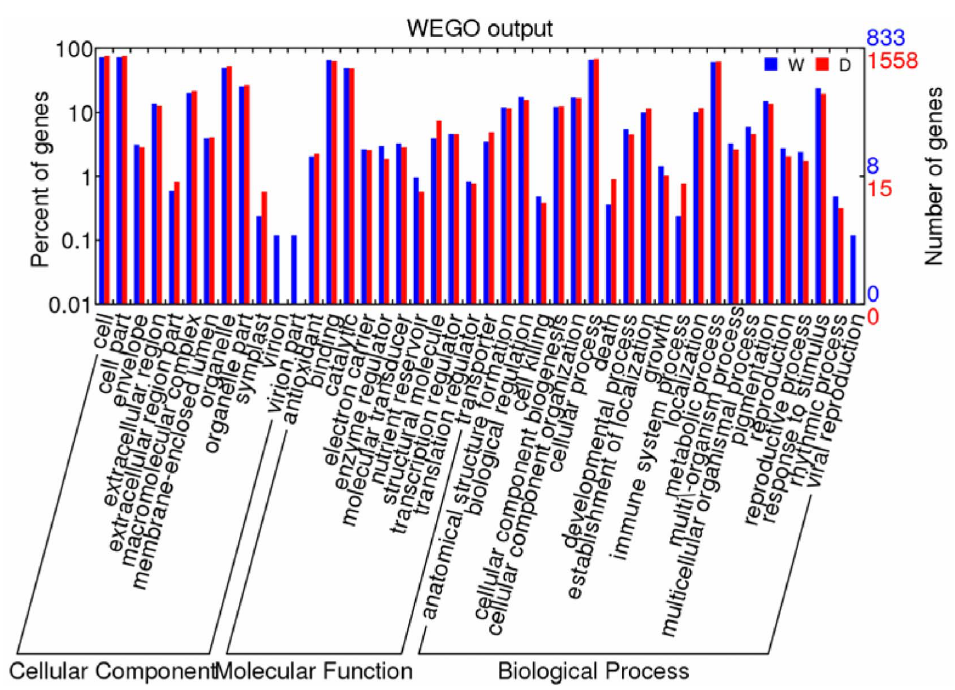
Figure 2. Histogram of functional Gene Ontology analysis of DEGs. The frequency of GO terms was analyzed using the GO Slim Assignment. The x- and y-axes represent the names of clusters and the ratio of each cluster, respectively. W, mechanical wounding; D, defoliation.